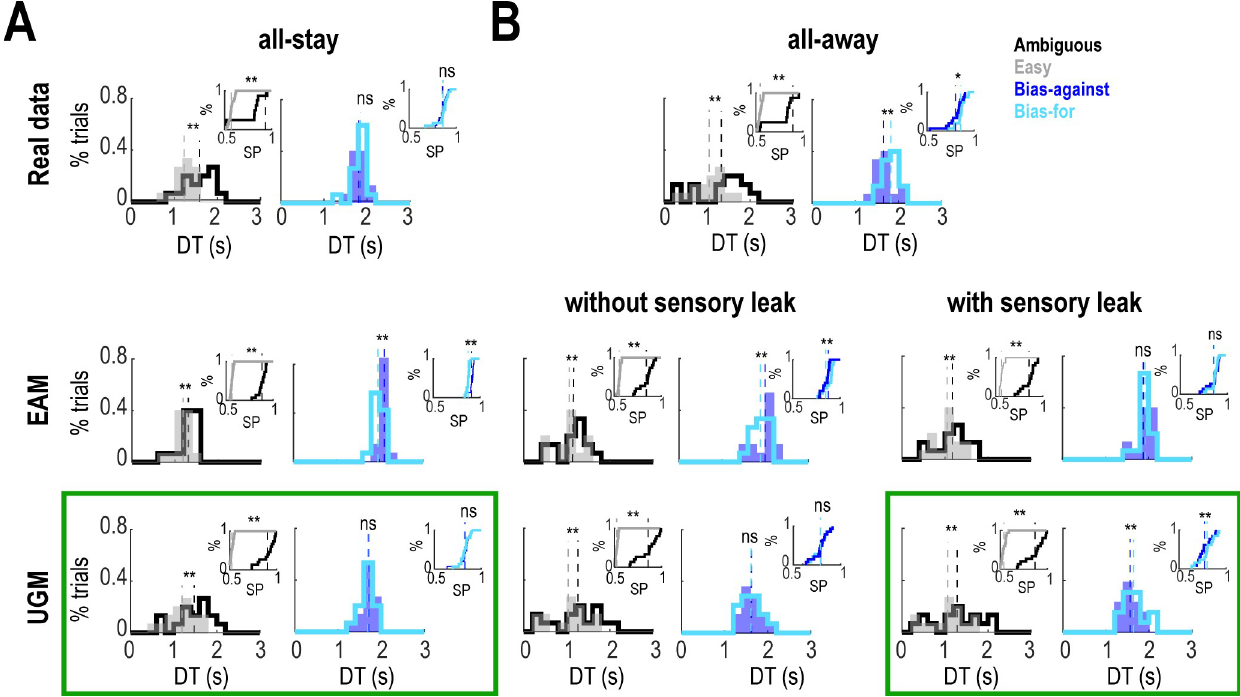
Fig 5. Model simulations for different trial types. (A) Distributions of DTs for ambiguous, easy, bias-for, and bias-against trials in real and simulated data in the all-stay condition. Inset panel , Cumulative distributions of SPs for each trial type. Differences in DTs and SPs in ambiguous and easy trials are fitted correctly by the EAM and the UGM (paired-samples t -test, �� p < 0.01). Lack of difference in DTs and SPs in bias-for and bias-against trials is only fitted by the UGM (paired-samples t -test, �� p < 0.01, ns: not significant). Dashed lines indicate the mean of the distributions. Green rectangle shows the results that are consistent with the real data. (B) Same conventions as in (A) for the all-away condition with simulations performed without and with leakage in the sensory evidence. Differences between DTs and SPs in easy and ambiguous trials are fitted correctly by the EAM and the UGM without and with sensory leakage (paired-samples t -test, �� p < 0.01). Longer DTs and higher SPs in bias-for than in bias-against trials are only correctly fitted by the UGM when sensory evidence leaks away (paired-samples t -test, � p < 0.05, �� p < 0.01, ns: not significant).